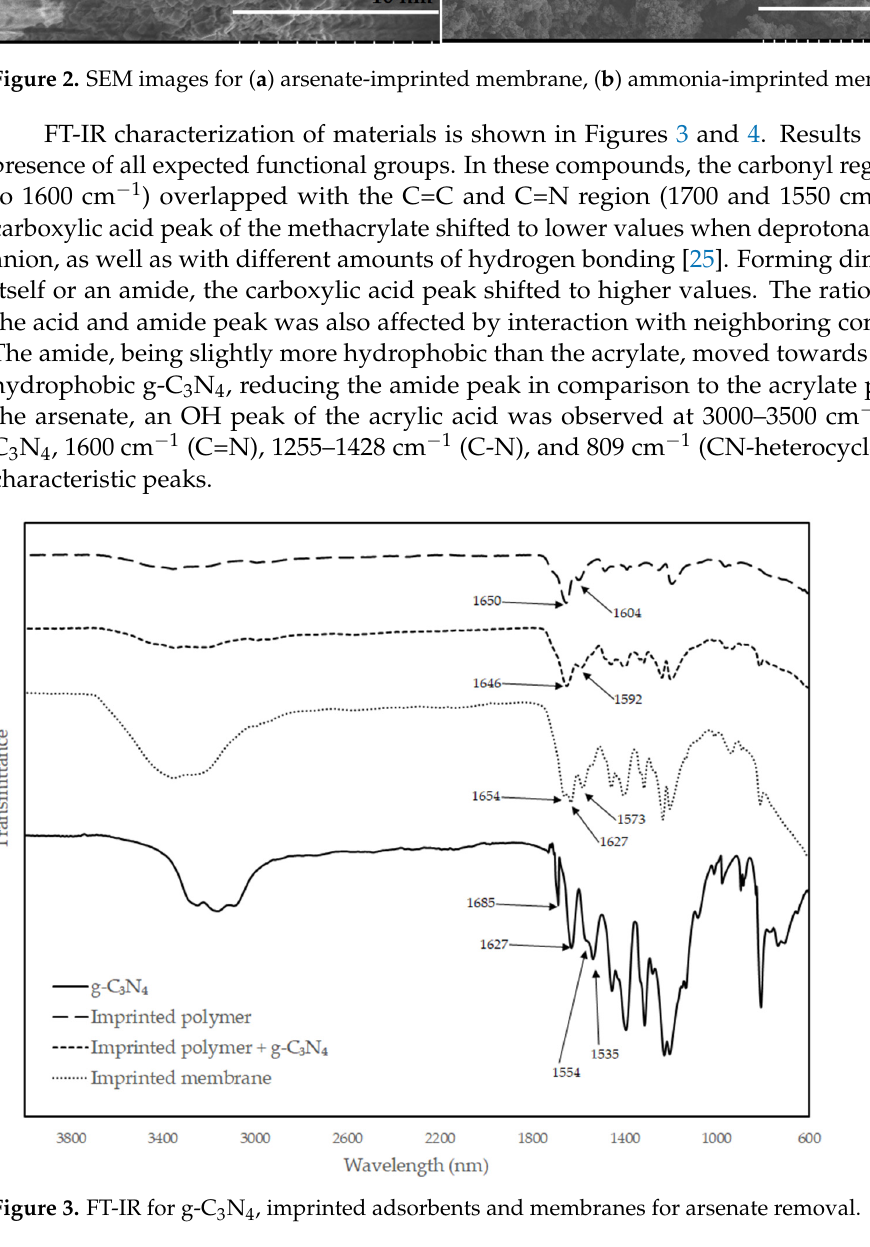
Figure 4. FT-IR for g-C 3 N 4 , imprinted adsorbent and membrane for ammonia removal.